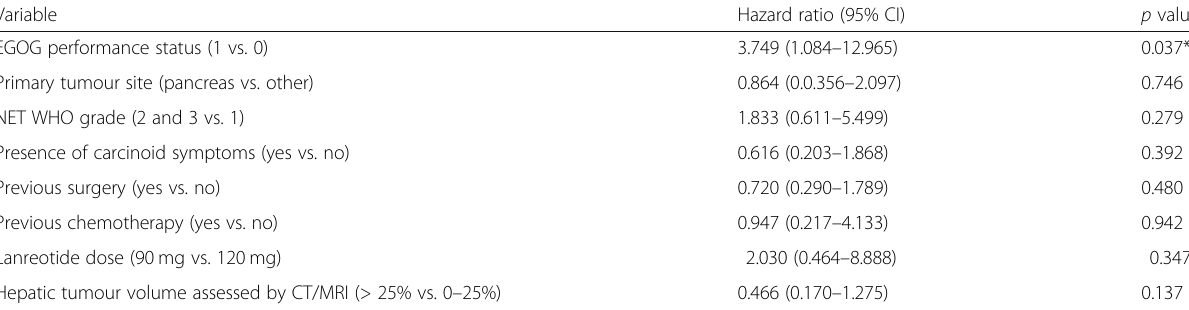
Table 3 Univariate analysis of clinicopathological variables for PFS after lanreotide therapy Variable Hazard ratio (95% CI) p value EGOG performance status (1 vs.